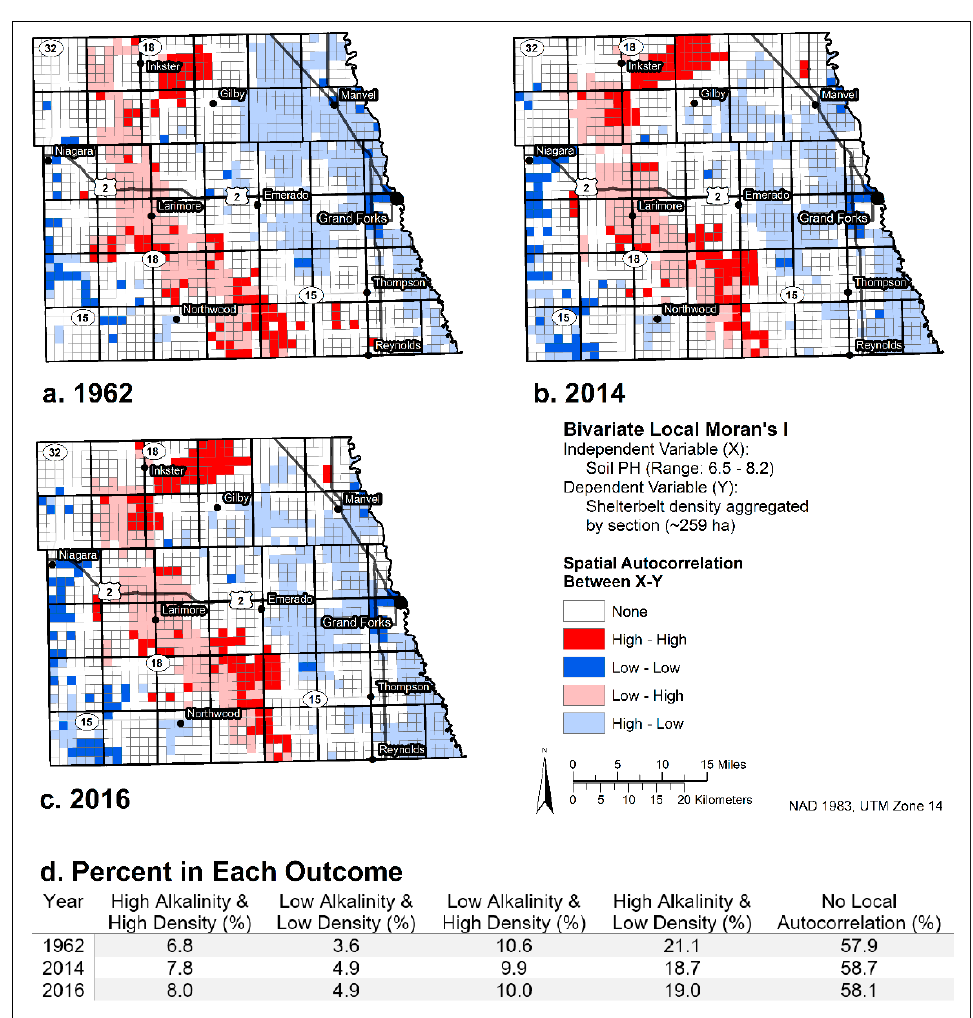
Figure 6. Bivariate Local Moran’s I testing the spatial autocorrelation between shelterbelt density and the Soil Survey Geographic Database soil pH, set at a 95% confidence interval for ( a ) 1962, ( b ) 2014, and ( c ) 2016. ( d ) The percentage of sections that fell under each possible outcome.